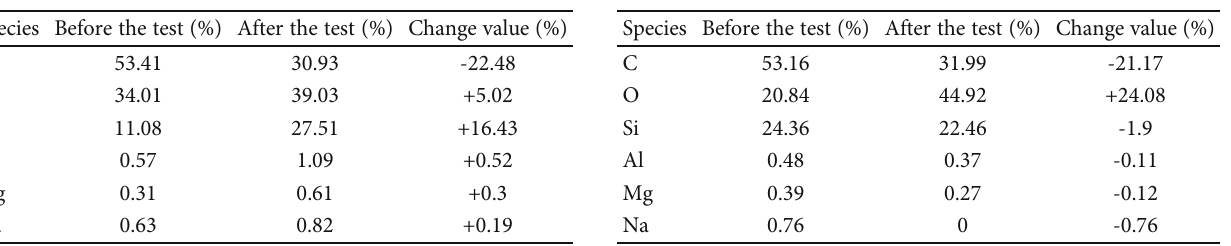
Table 3: EDS results of the